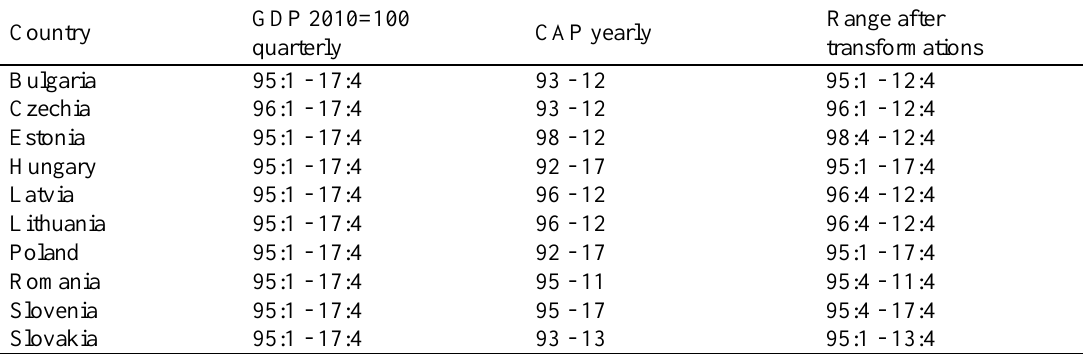
Table 2. Frequency of